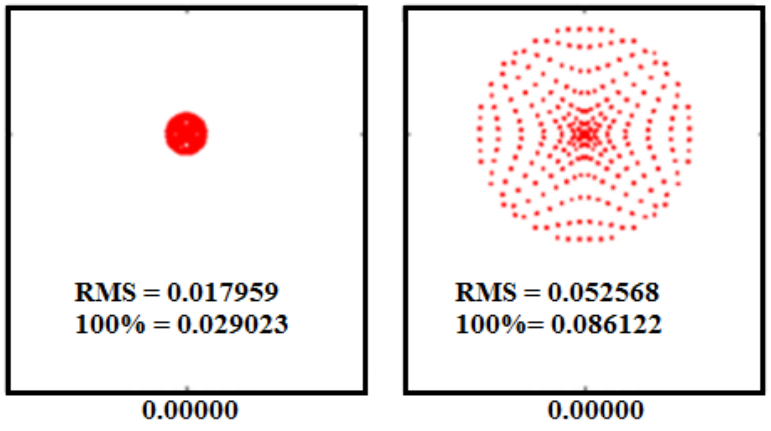
Figure 8. Spot diagram of optical system before and after receiving heat.